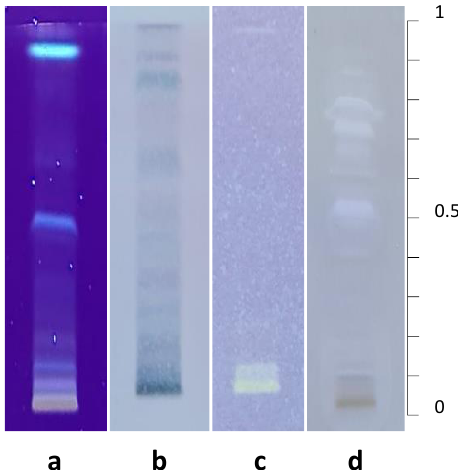
Figure A2. COX-2 TLC assay with increasing quantities of ( A ) celecoxib and ( B ) diclofenac.